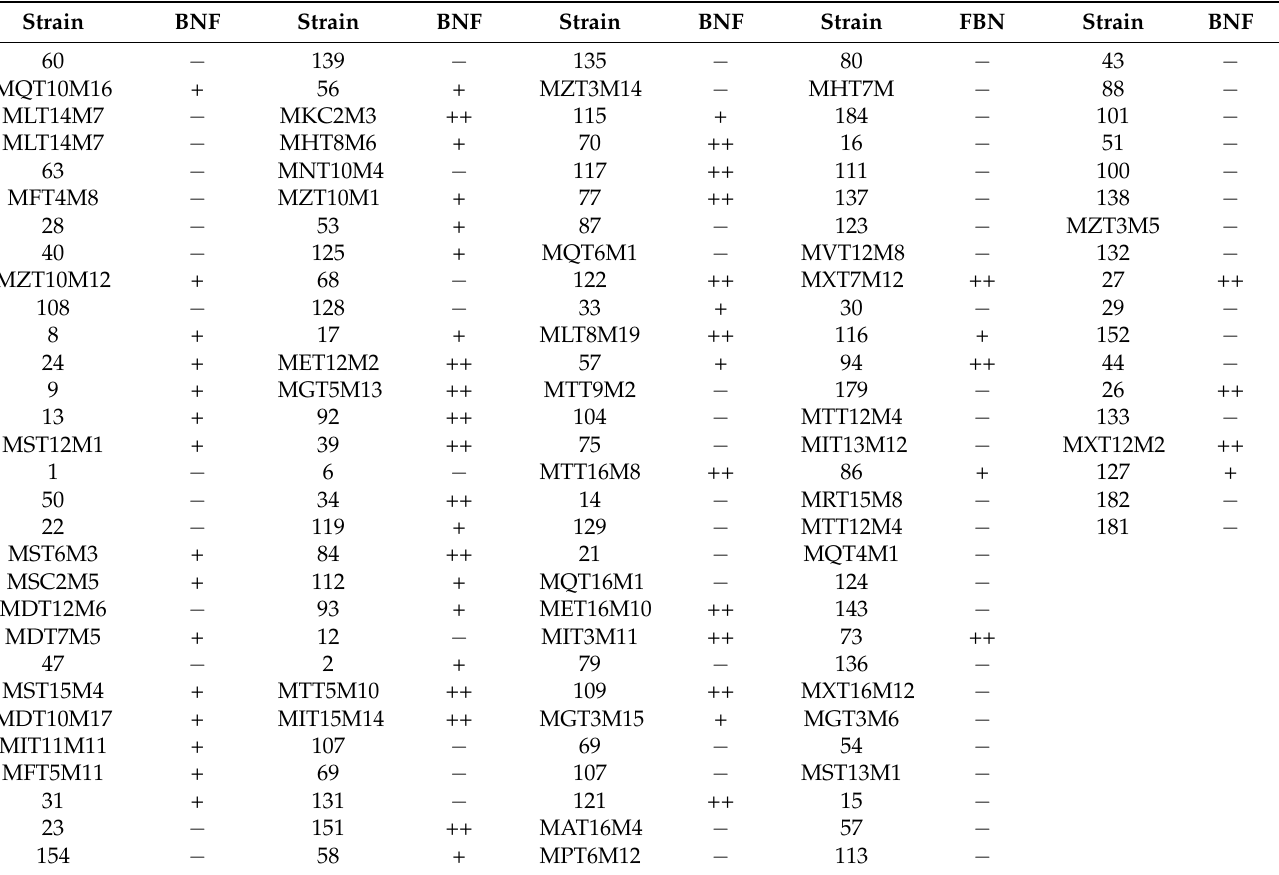
Table 2. Asymbiotic nitrogen fixation by strawberry endophytic bacteria (qualitative